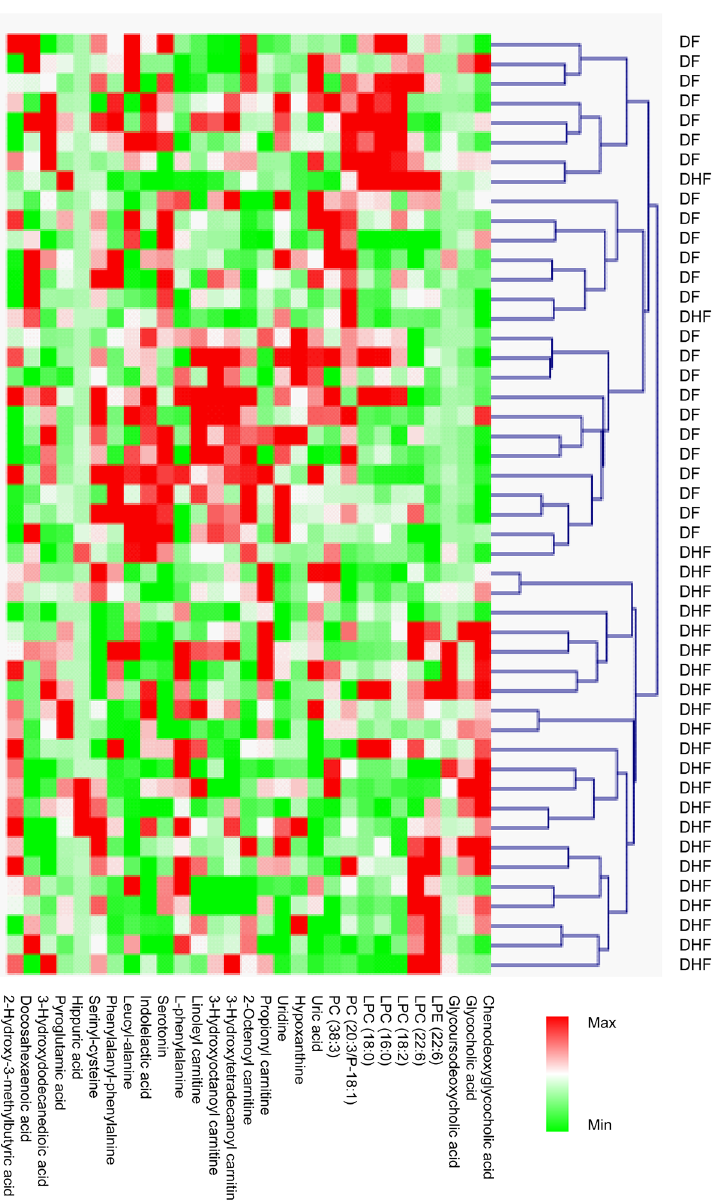
Fig 1. Hierarchical heatmap clustering with identified differentially expressed metabolites segregates critical phase dengue fever (DF) and dengue hemorrhagic fever (DHF) patients. Each column shows ion intensity for a specific metabolite after mean centering and unit variance scaling of the data. Each row shows the serum metabolic profiles of DF and DHF patients.